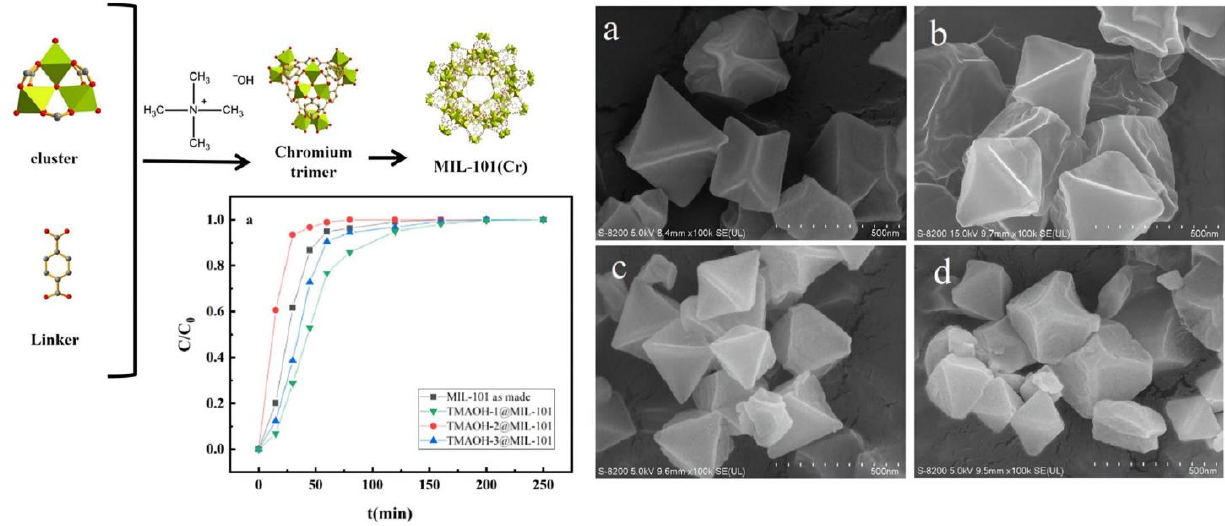
Figure 4. Synthesis process of MIL-101(Cr) ( left ) (the inset shows the adsorption capacity curve of the sample for toluene) and SEM images of MIL-101(Cr) ( right ); ( a ) MIL-101(Cr) as made; ( b ) TMAOH-1@MIL-101(Cr); ( c ) TMAOH-2@MIL-101(Cr); ( d ) TMAOH-3@MIL-101(Cr) [48] . Reprinted from ref. [48]. Copyright © 2022, with permission from Elsevier.